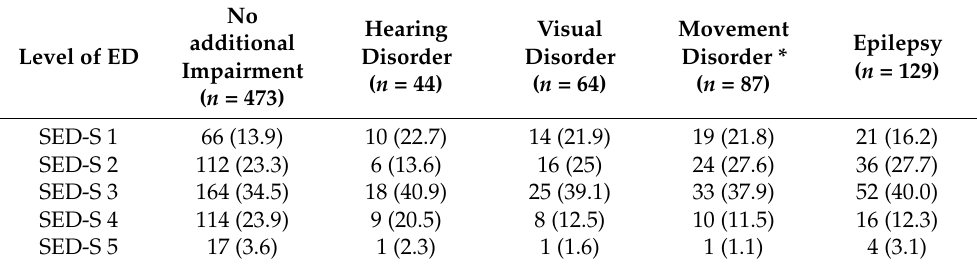
Table 2. The Different Impairments and Levels of Emotional Development.